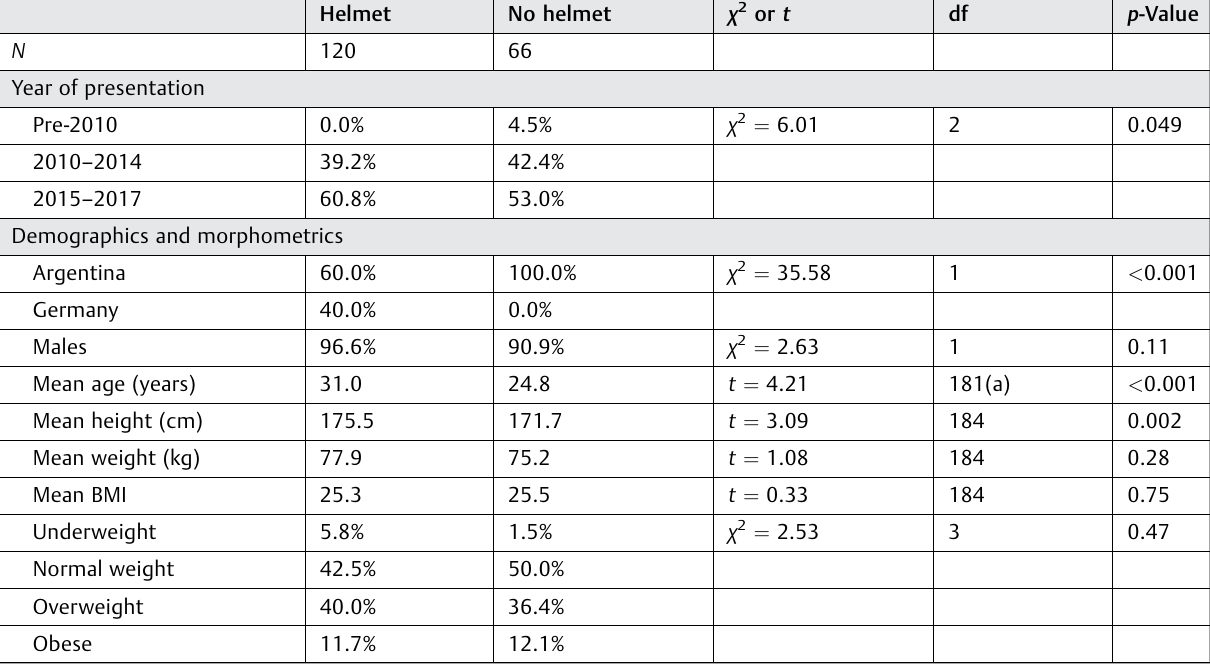
Table 2 Demographics and morphometrics in patients wearing versus not wearing a